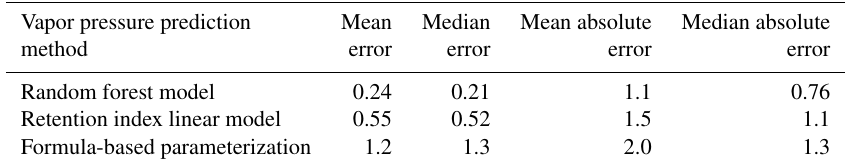
Table 4. Error distribution metrics random forest model, retention index linear model, and formula-based predictions of vapor pressure. All reported errors in units of log(vapor pressure(atm)).